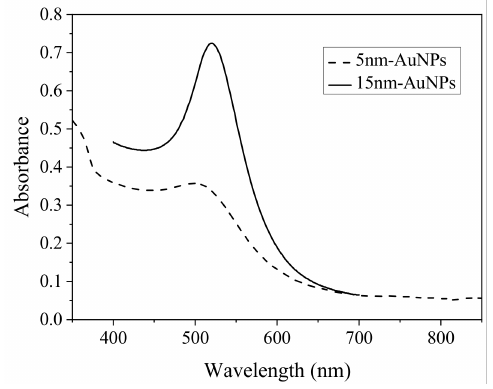
Figure 2. UV-vis spectra of AuNPs.